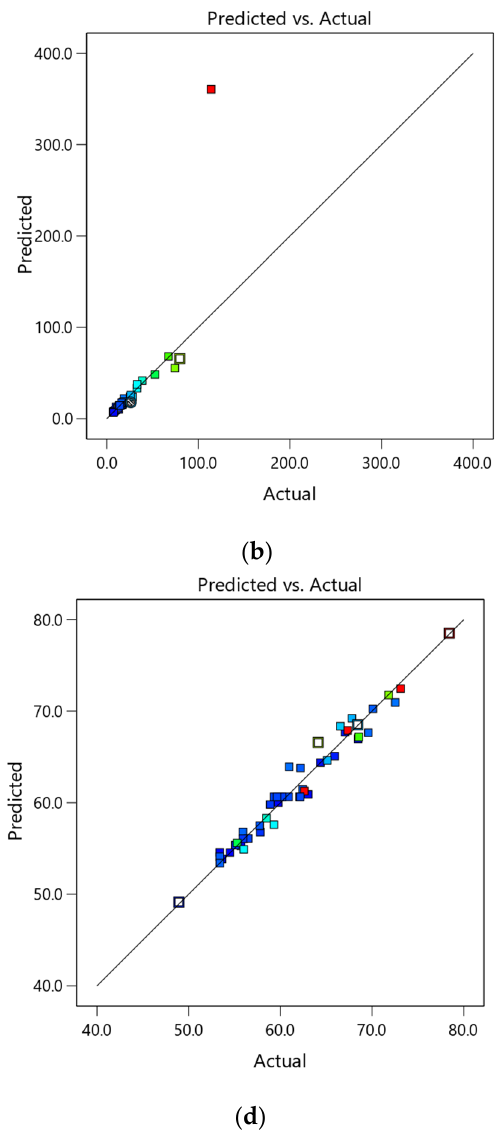
Vw/Vp on ( c ) F,24 h and ( d ) Rc,24 h.